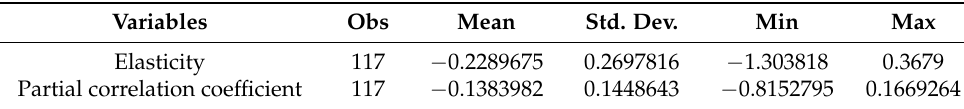
Table 3. The descriptive statistics of the two effect